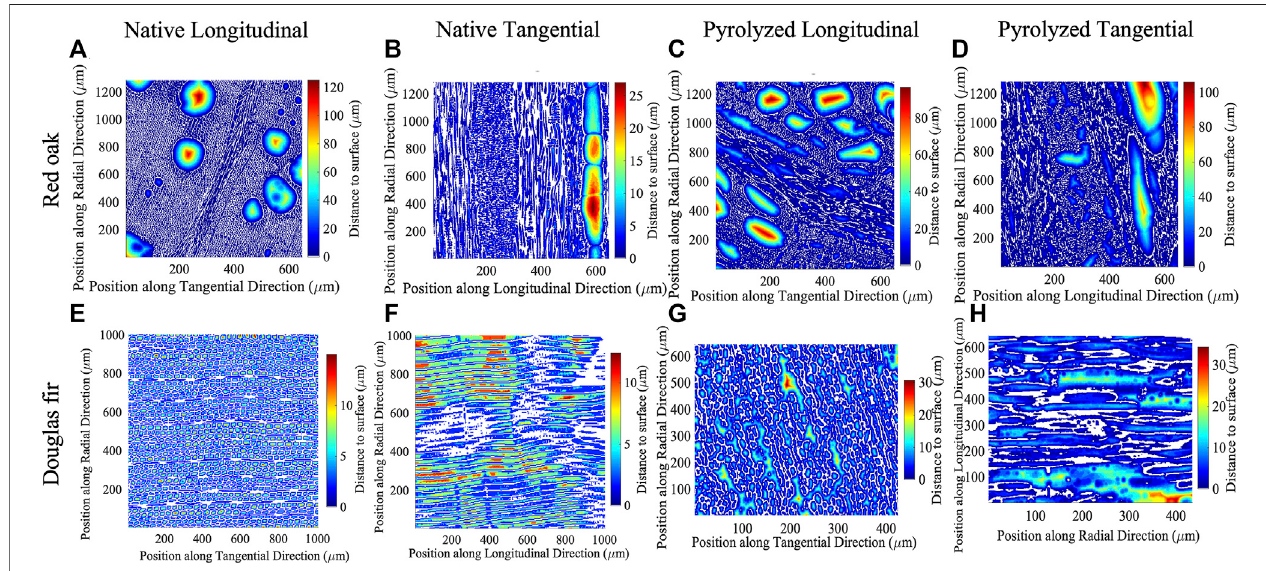
FIGURE 4 | Distance-to-surface map of each sample normal to longitudinal and transverse directions: (A) native red oak normal to the longitudinal direction, (B) native red oak normal to the tangential direction, (C) pyrolyzed red oak normal to the longitudinal direction, (D) pyrolyzed red oak normal to the tangential direction, (E) nativeDouglas fi rnormaltothelongitudinaldirection, (F) nativeDouglas fi rnormaltothetangentialdirection, (G) pyrolyzedDouglas fi rnormaltothelongitudinaldirection, (H) pyrolyzedDouglas fi rnormal tothetangentialdirection.Slices shown aretaken fromthe middle oftheanalyzed XCT reconstruction sub-volumes. Note thatthe scalebars are unique to each